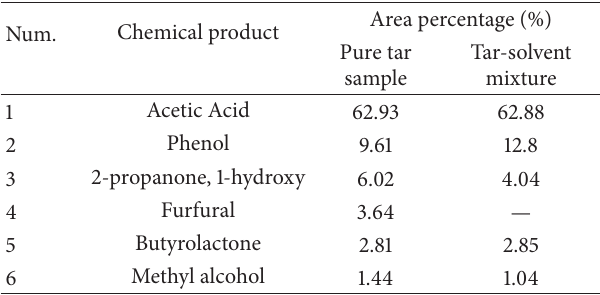
Table 7: Major tar components detected by MS and their relative area